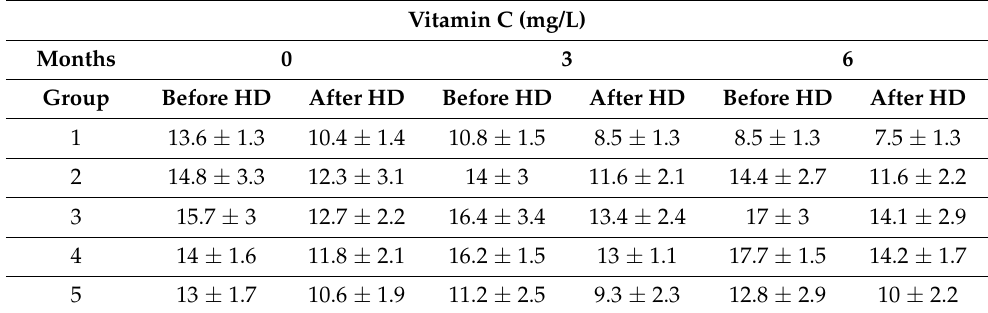
Table 4. Comparison of serum vitamin C concentrations (mg/L) between groups before and after HD during 6 months of the study.